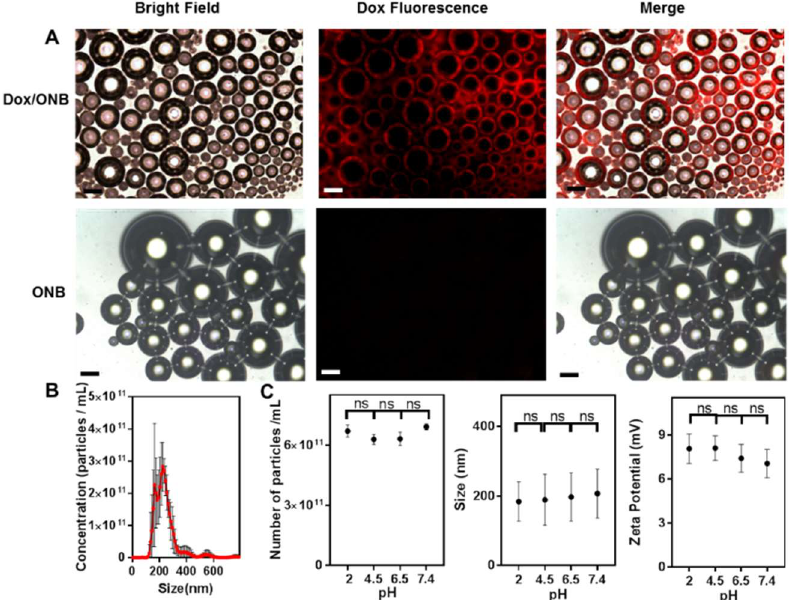
Figure 2. Characterization of Dox-encapsulated microsized and nanosized bubbles. ( A ) Bright field, fluorescence, and merged images of Dox-encapsulated microbubbles and ONB (without Dox) in a total solution containing both nanoscale and microscale bubbles. Scale bar = 20 µm. ( B ) Size distribution and concentration obtained by nanoparticle tracking analysis (NTA) for Dox-conjugated oxygen nanobubbles (Dox/ONB). ( C ) Comparison of the number of particles, size, and zeta potential of ONBs at different pH values. ns: no significant difference.